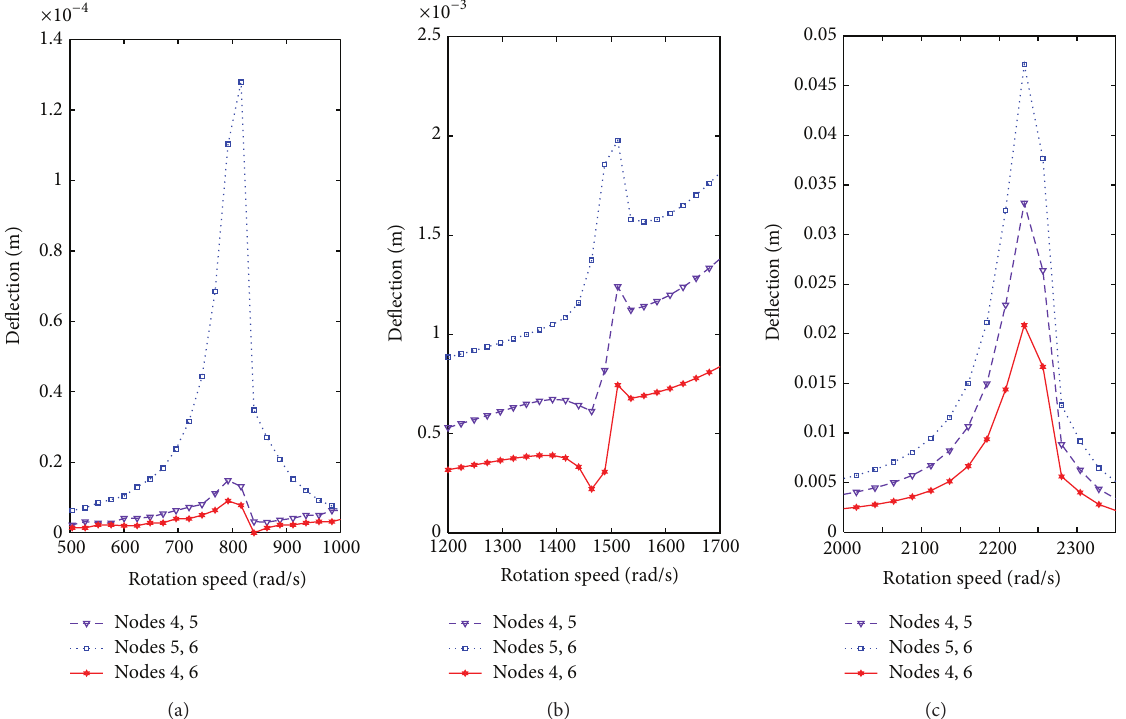
Figure 8: Transient resonance peak response versus speed of bearing 1 (node 2) with balancing (—) and without correction mass (---): (a) first critical speed, (b) second critical speed, and (c) third critical